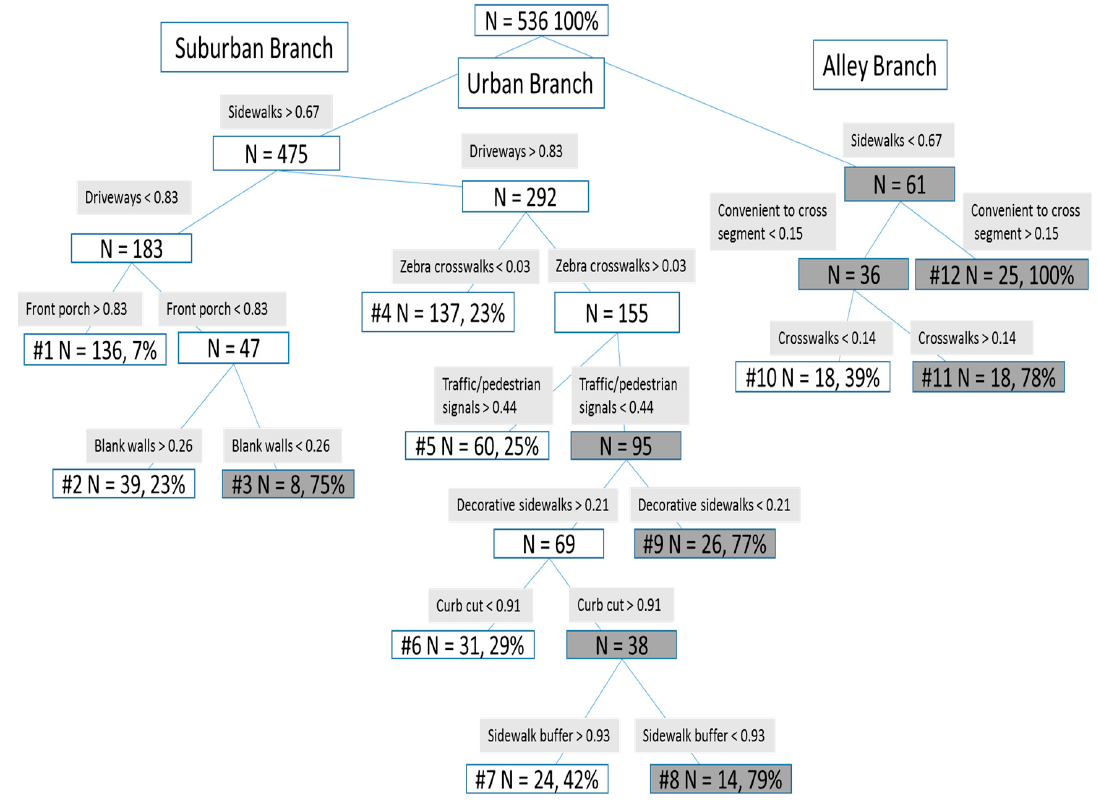
Figure 2. Decision tree results. Note. Grey nodes indicate predicted active transportation on the complete street. Percent in terminal nodes indicates percent of participants in that node who had global positioning system (GPS)-verified active transportation on the complete street.